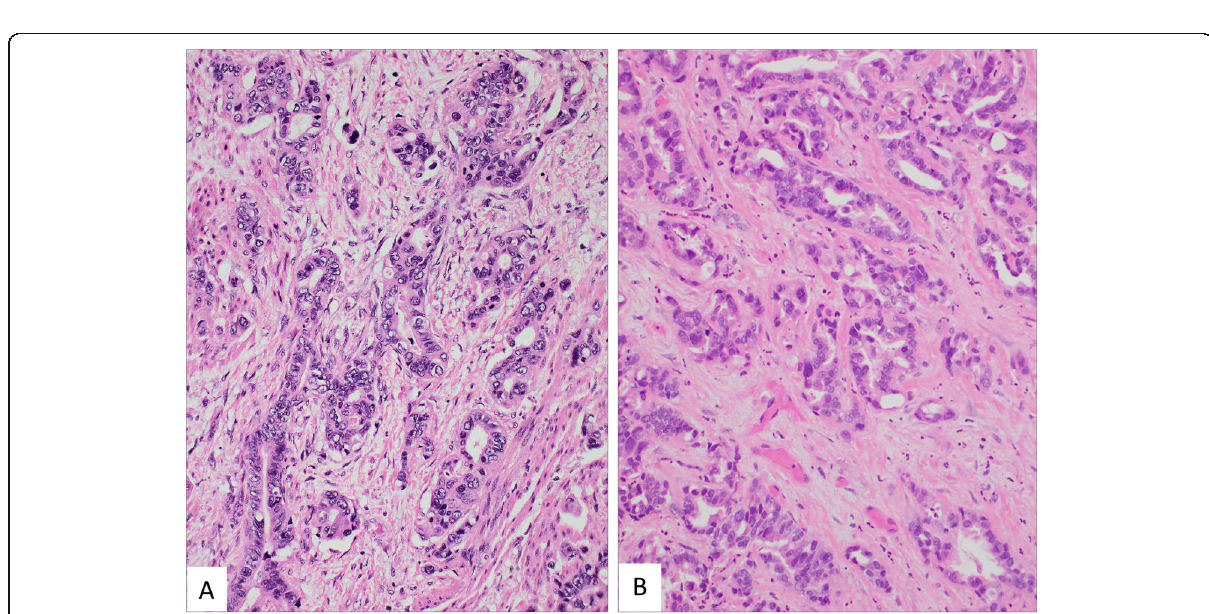
HPV, MUC-6, and p53. P16 is a surrogate marker for HPV-related malignant lesions and is a useful adjunct in confirmation of UEA on cervical biopsy. If it is negative or shows a mosaic pattern, MUC-6 and p53 IHC may aid in the diagnosis of GAS. The immunohistochemical profile of GAS is similar to normal gastric mucinous cells with expression of MUC-6, HIK 1083. GAS cells produce neutral cytoplasmic mucin that stains red with combined Alcian blue/ periodic-acid-Schiff (PAS) stain, while normal endocervical glands cells/UEA contain an admixture of acid and neutral mucin that stains a purple-violet color with Alcian blue/PAS. Immunohisto- chemical markers, MUC-6 and HIK-1083, both detect pyloric gland mucin, and support gastric-type differenti- ation. In this study, all the GAS cases were MUC-6 posi- tive and p16 negative. In the literature, there is a wide variability in MUC − 6 expression and varies from 40 to 81 to upto 100% [5, 14, 17 – 21]. Some of this variability may be due to methodology and or use of tissue micro- array. In addition, MUC-6 is positive in approximately 8% of benign epithelial cells, normal endometrial glands, and significant number of endometrial endometrioid carcinomas [22]. In contrast, HIK-1083 stains only 2% of benign epithelial cells and negative in all types of endo- metrial carcinoma. These findings suggest a cautious in- terpretation of MUC 6 IHC to differentiate between benign and malignant mimics of GAS. HIK1083 has